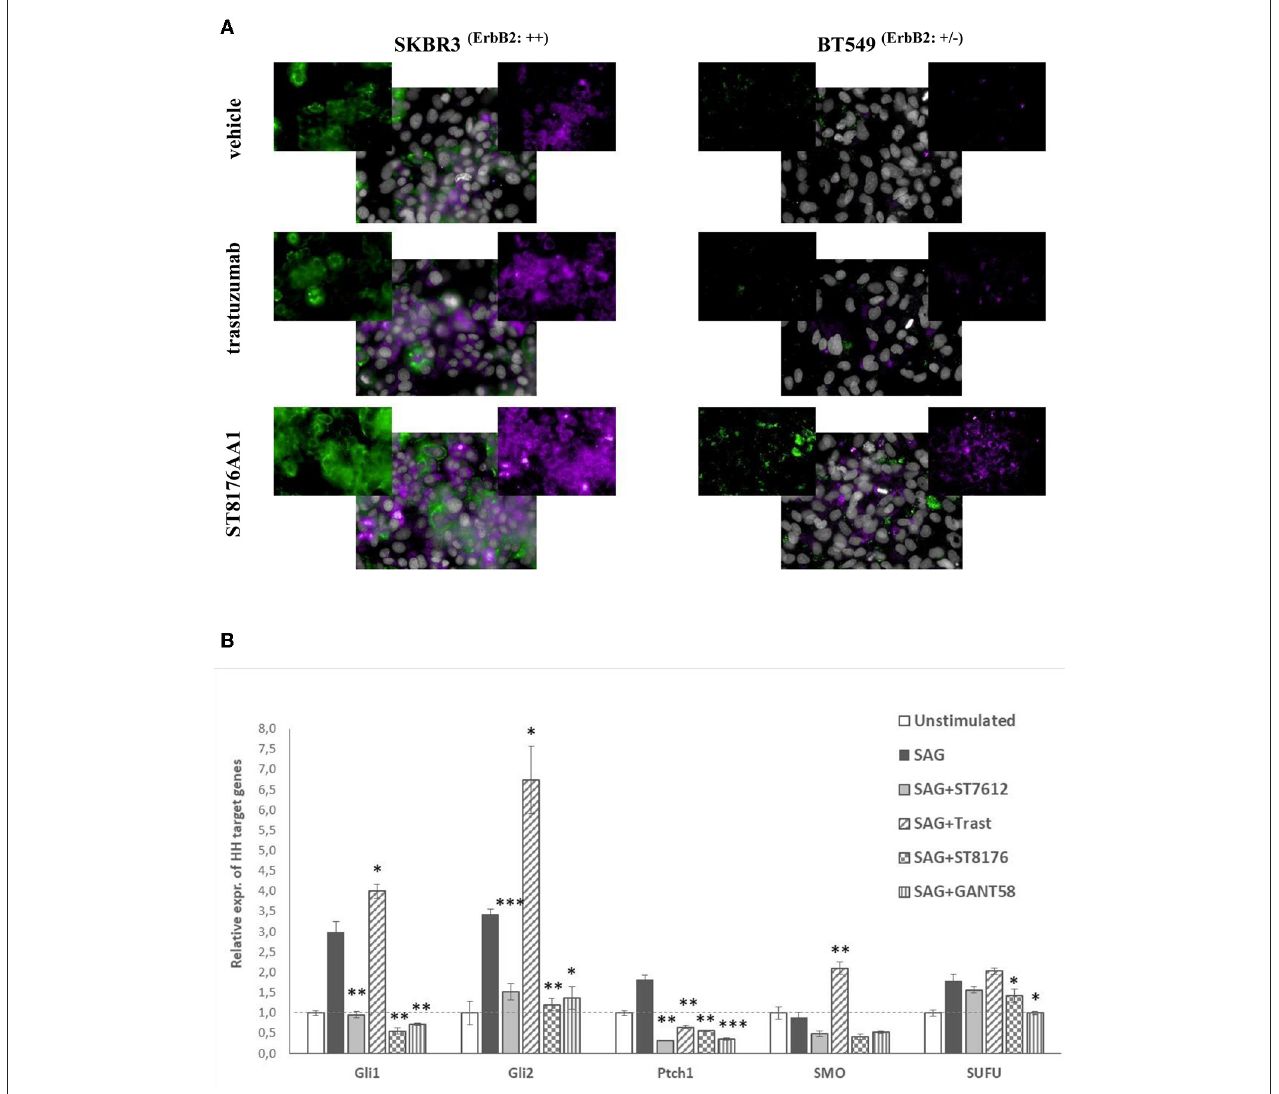
FIGURE 7 | ST8176AA1 induces the expression of ER α and ErbB2 in ErbB2 + and triple negative breast cancer cells. (A) HCS fluorescence imaging analysis show that ErbB2-positive (SKBR3) and triple negative (BT549) breast cancer cells treated with ST8176AA1 exhibit increased expression of ER α (purple) and ErbB2 (green) proteins, compared to trastuzumab. ST8176AA1 and trastuzumab were used at 5 µ g/mL (3 days incubation). Basal ErbB2 expression scored by cytofluorimetry in brackets. In all panels, insets show specific fluorescence signals within the cells. Draq5 dye staining of nucleus (gray). Each image is representative of at least five fields of duplicate wells. Magnification 60X. Data are from one representative experiment out of two. (B) SAG-induced Hh target gene expression measured by qPCR in LS174T cells after 24 h-treatment with ST7612AA1 (100nM), ST8176AA1 or trastuzumab (250nM) and with the reference Hh inhibitor GANT58 (10 µ M). Graph displays the relative expression of the indicated target genes (after normalization to the housekeeping gene GUSB) as compared to not stimulated cells. Data are mean of triplicates ± SD. Student’s t -test: *** P ≤ 0.001; ** P ≤ 0.01, and * P ≤ 0.05 vs.